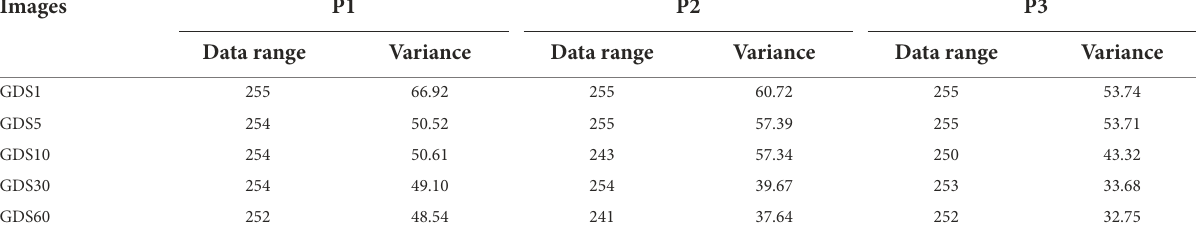
TABLE 3 Statistical analysis of G band DN values at each growth